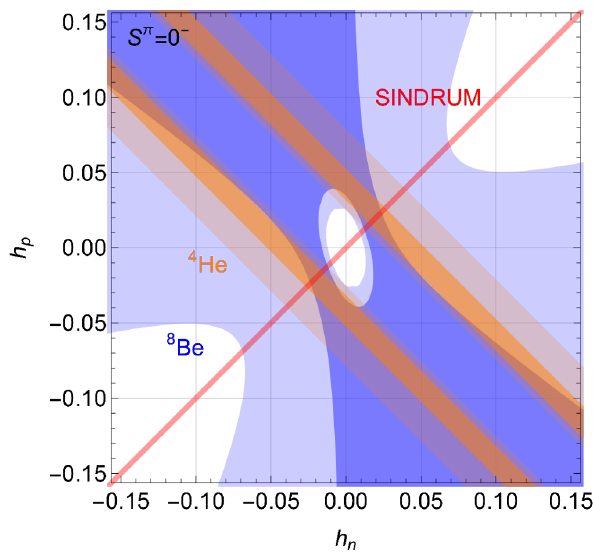
Figure 4 . Regions of the h n,p effective nuclear couplings of a pure pseudoscalar states where the 8 Be (blue) and 4 He (orange) anomalous ATOMKI transition can be explained at 1 σ or 2 σ . Inside the red region the SINDRUM bound is